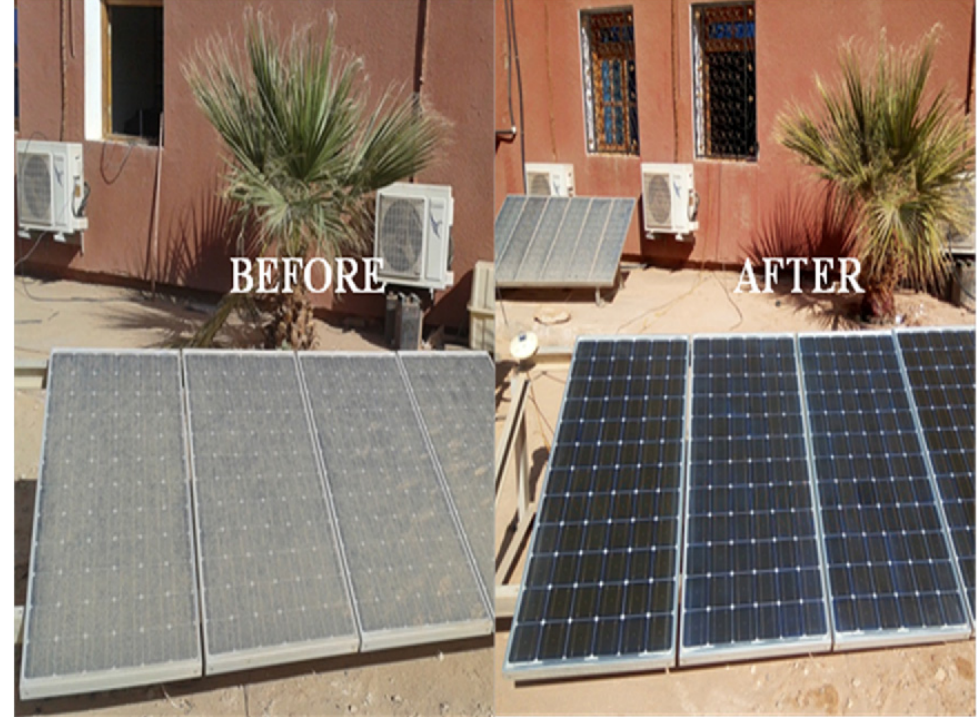
Figure 20. PV panels before cleaning and after cleaning [113].